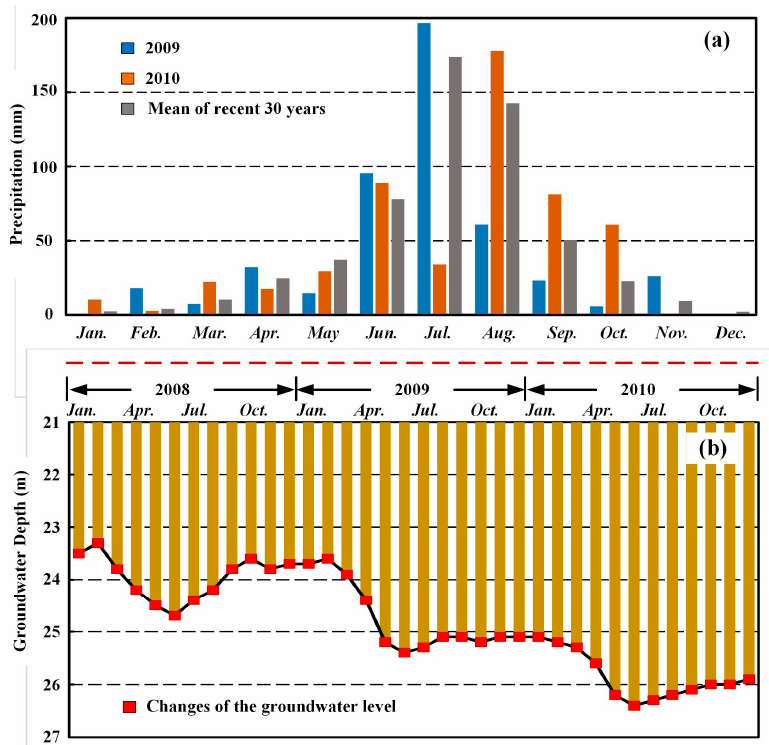
Figure 2. ( a ) Monthly precipitations of 2009 and 2010 and the mean values calculated from the last 30 years; and ( b ) groundwater variations of Beijing City in the period of 2008–2010.